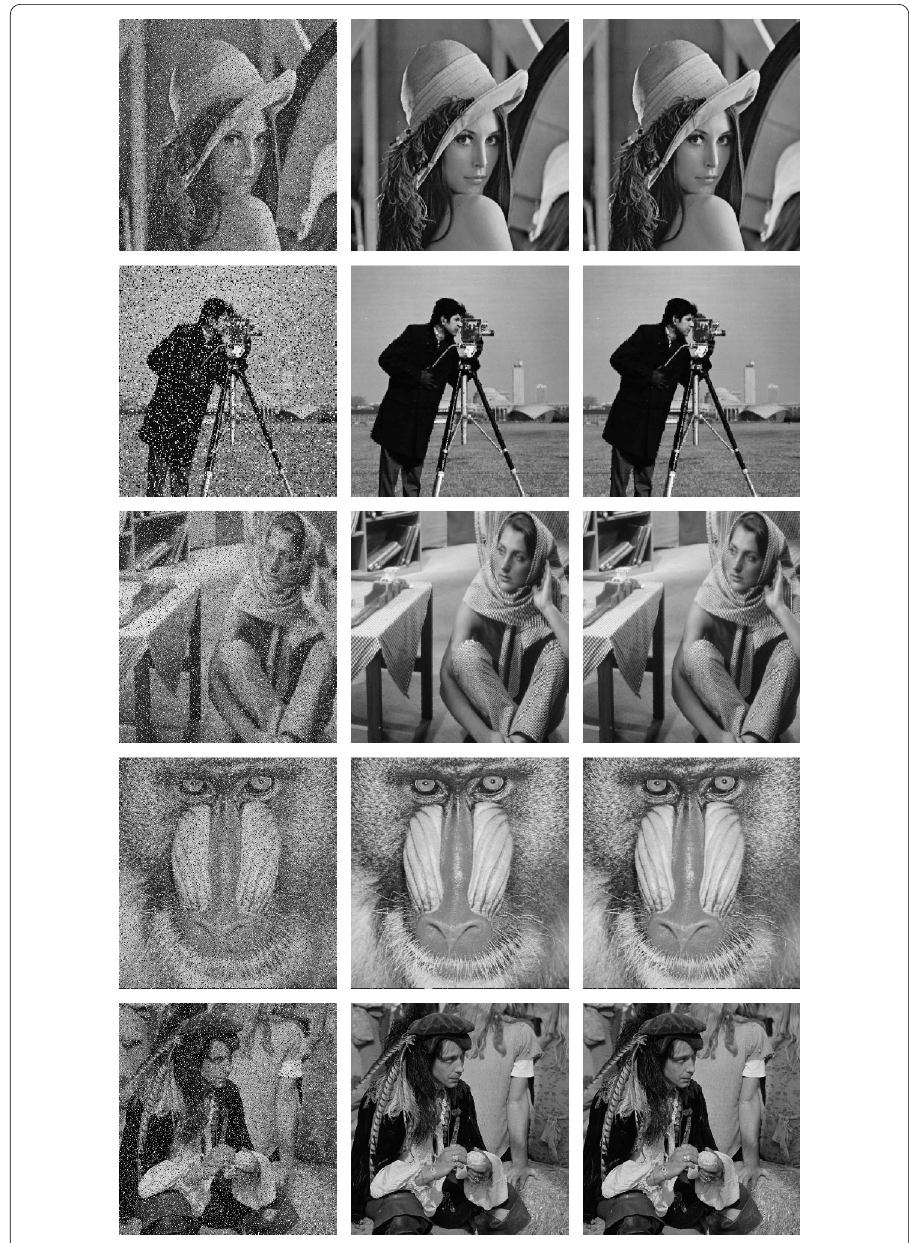
Figure 7 Restoration of the images Lena, Cameraman, Barbara, Banoon, and Man by PRP algorithm and Algorithm 3.1. From left to right: the noisy image with 20% salt-and-pepper noise, the restorations obtained by minimizing z with PRP algorithm and Algorithm 3.1,